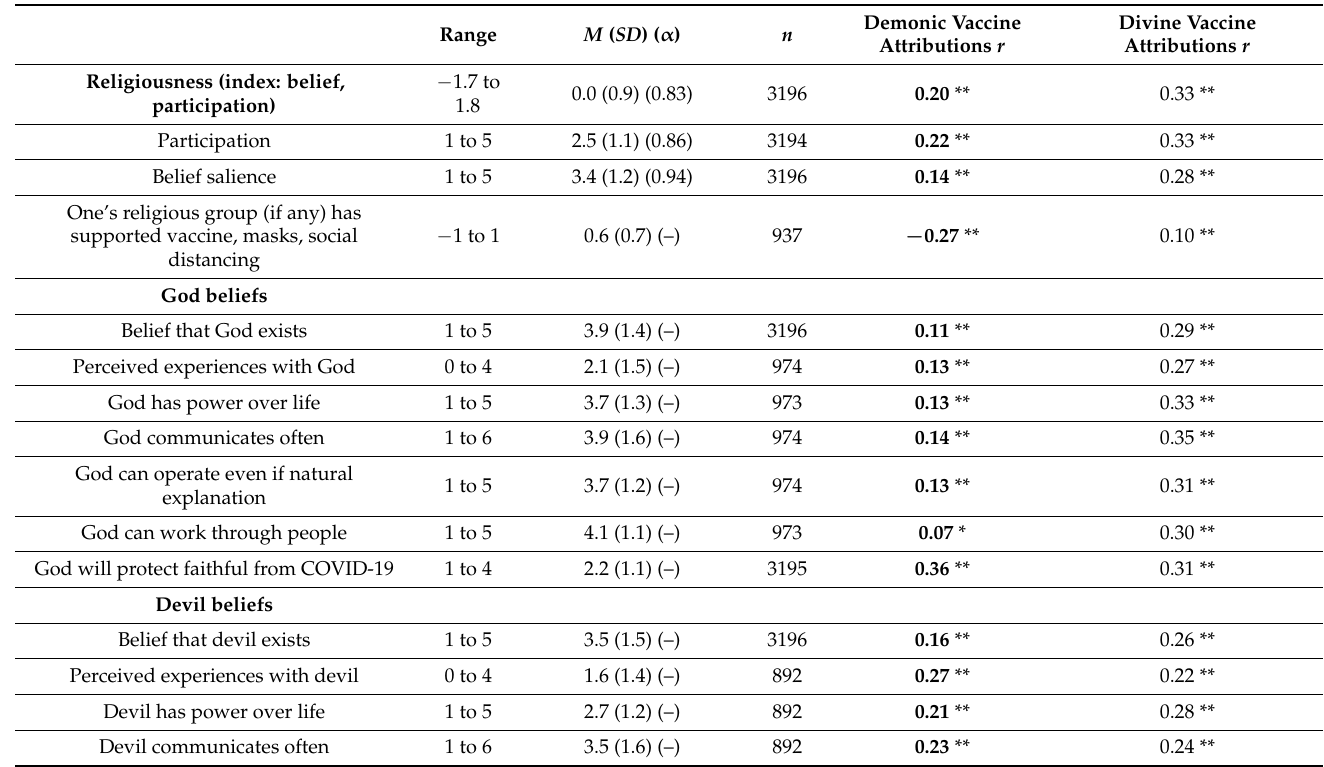
Table 5. Religiousness and Beliefs about God, the Devil, and the Afterlife: Descriptive Statistics and Correlations with Demonic and Divine Vaccine